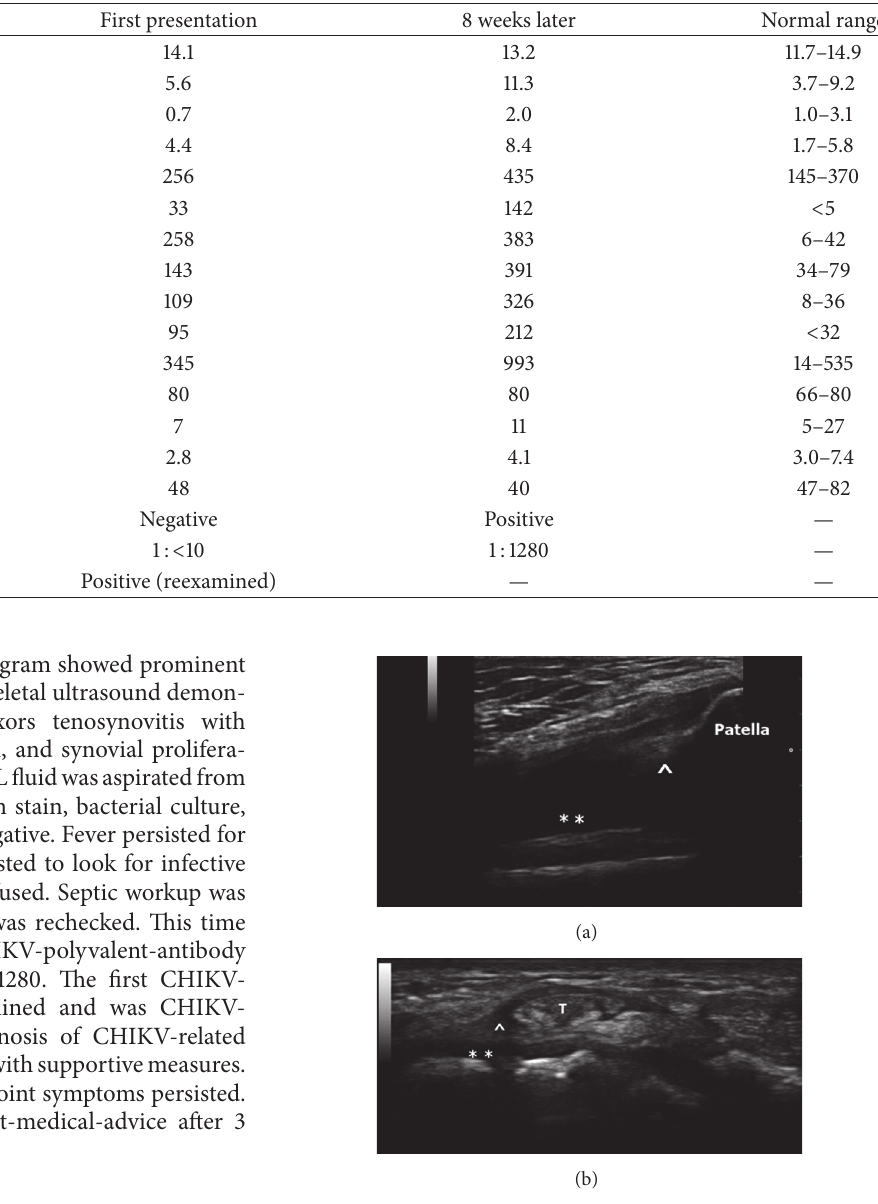
Table 1: Summary of laboratory investigations.